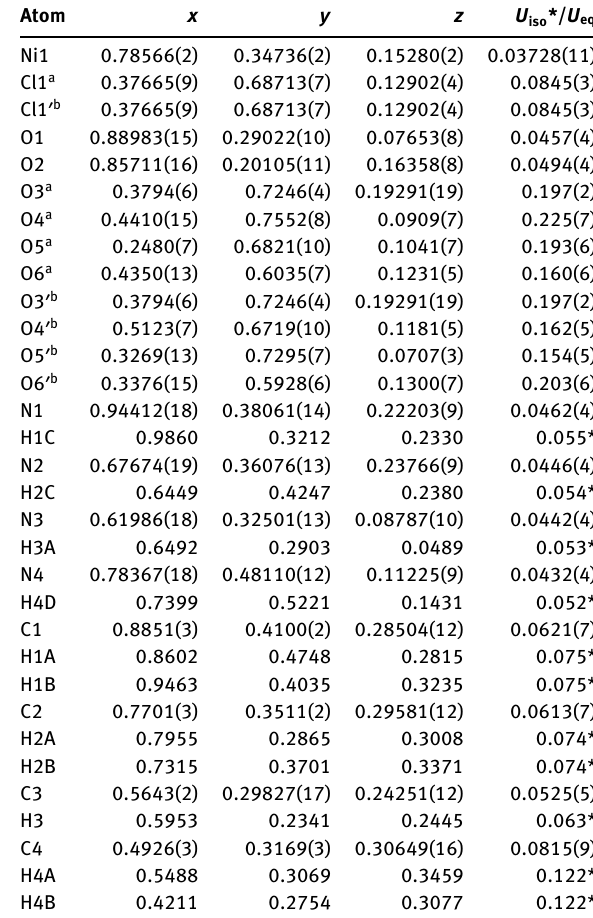
Table 2: Fractional atomic coordinates and isotropic or equivalent isotropic displacement parameters (Å 2